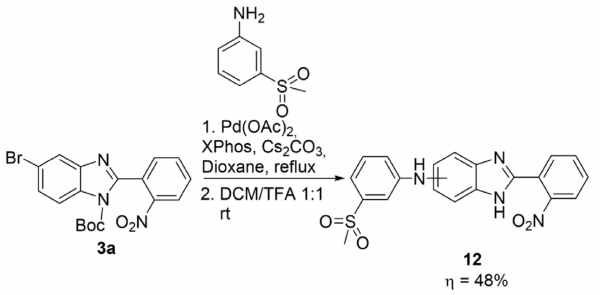
Scheme 4. Buchwald–Hartwig coupling involving boc-protected benzimidazole ( 3a ), and subse- quent